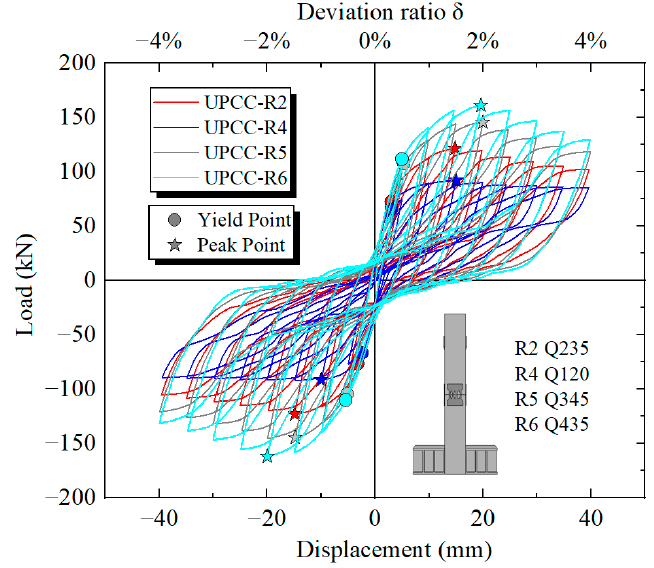
Figure 23. Hysteretic curves under different steel yield strength of EREDL.